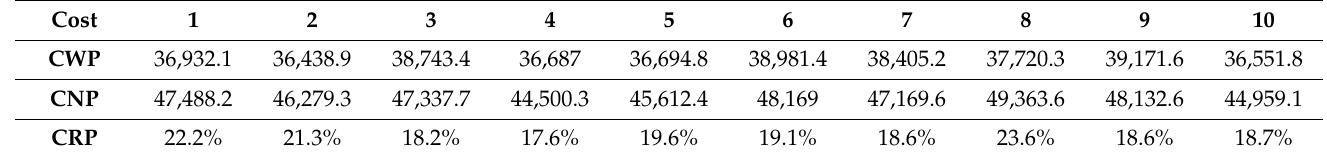
Table 1. Computational results of the first instances set in Case 1.